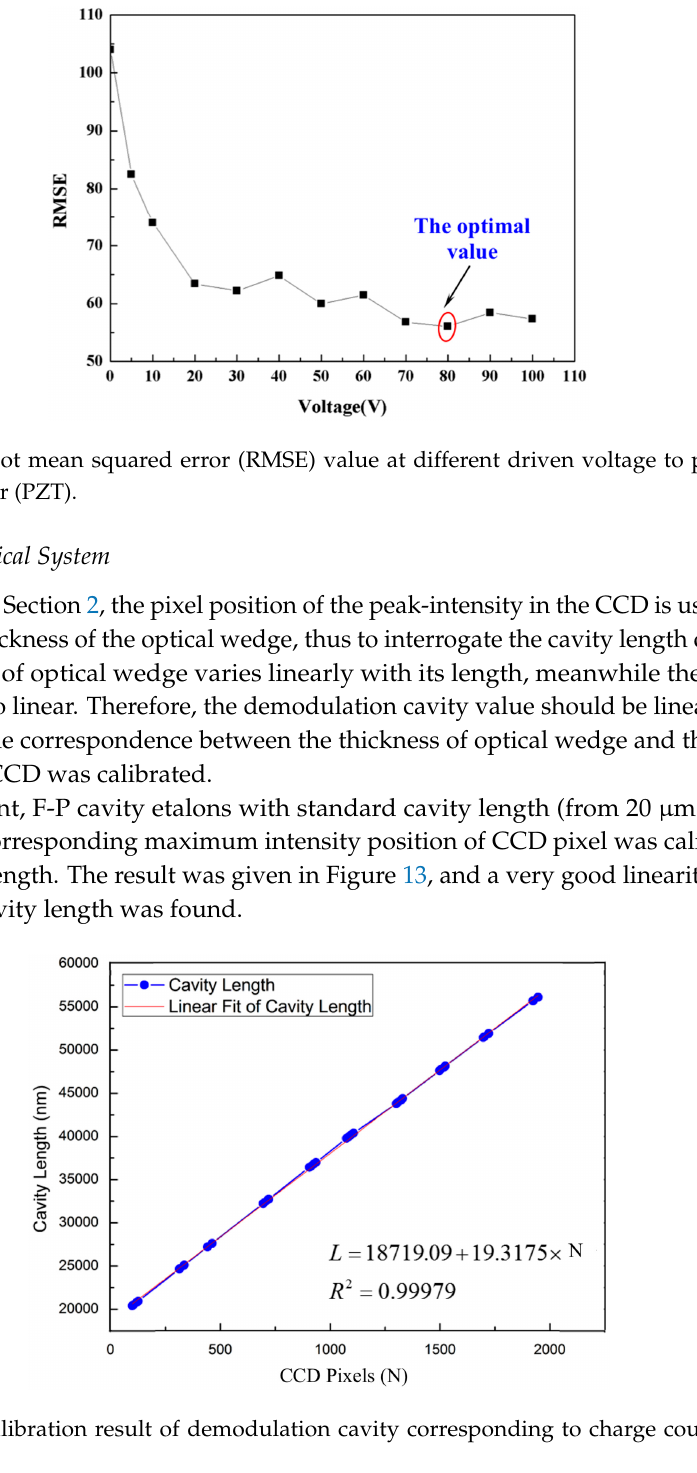
10 of 13 Figure 11. The experimental output of spectrum with the driven voltage of 0 V, 40 V, and 80 V. Here, a parameter root mean squared error (RMSE) is calculated to evaluate the stability of output, which is given by